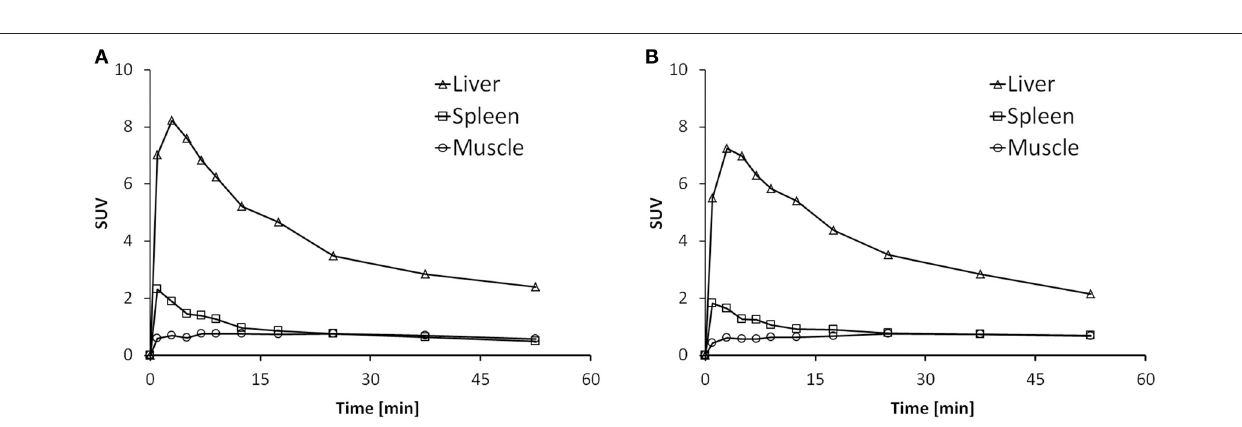
FIGURE 6 | Representative time activity curves (TACs) showing the standardized uptake values (SUV) of spleen, liver, and muscle in the time course of 60 min after injection of [ 11 C]AAT-015 into Wistar rats. (A) Injection of tracer only; (B) Injection of tracer and 1.5 mg/kg GW405833 (shortly before